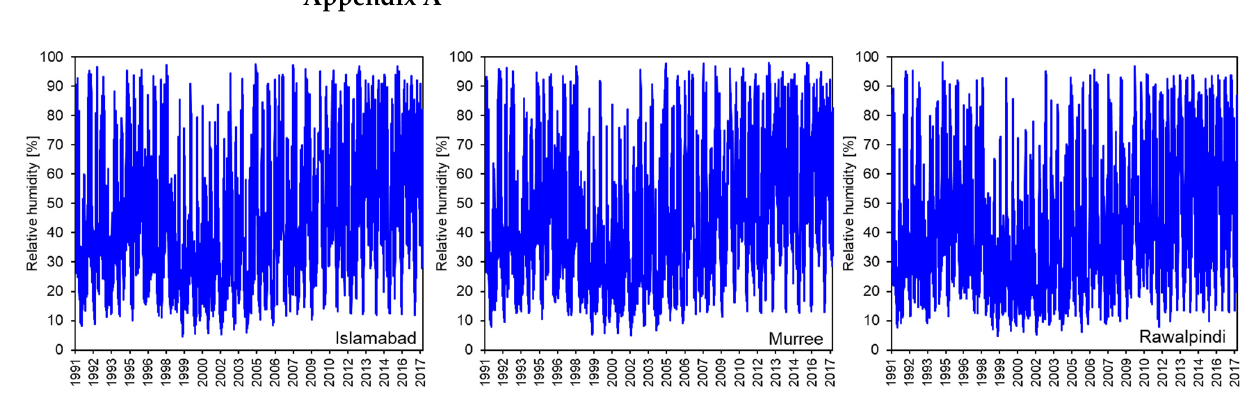
Figure A1. Temporal relative humidity profiles of baseline period for Islamabad, Murree, and Rawalpindi.